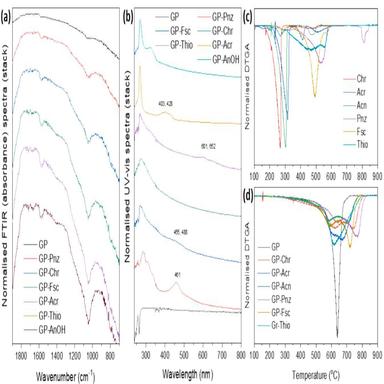
(a) Normalised FTIR spectra (absorbance mode) of the materials; (b) Normalised UV–vis absorption spectra of the materials in water. TGA first derivative (DTGA) plots for (c) starting amines and (d) graphene and modified graphene samples.